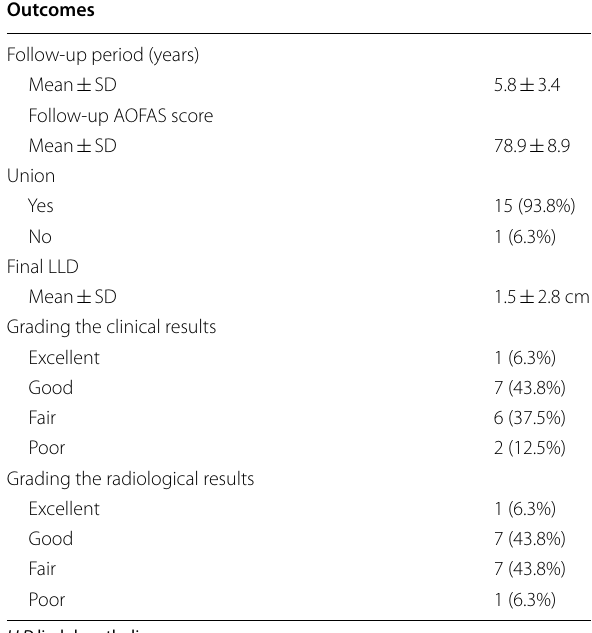
Table 5 Summary of the